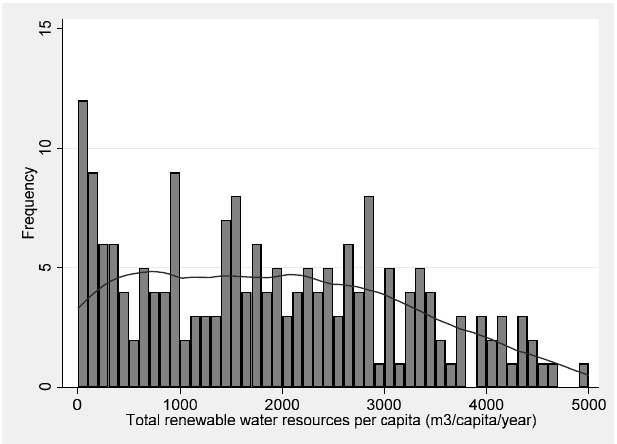
Figure 2. The figure shows the frequency distribution and kernel density of the total renewable water resources per capita for water-scarce countries for the full sample.